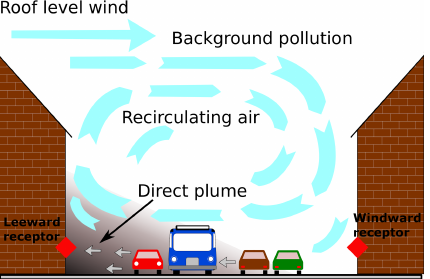
Figure 3. Cross section of a street canyon. The figure illustrates the governing flow patterns as modelled in OSPM. The two receptors are marked with red diamonds. In the figure the recirculation zone occupies the whole canyon although this need not be the case as e.g. shown in the following figures. Figure modified from Silver et al.